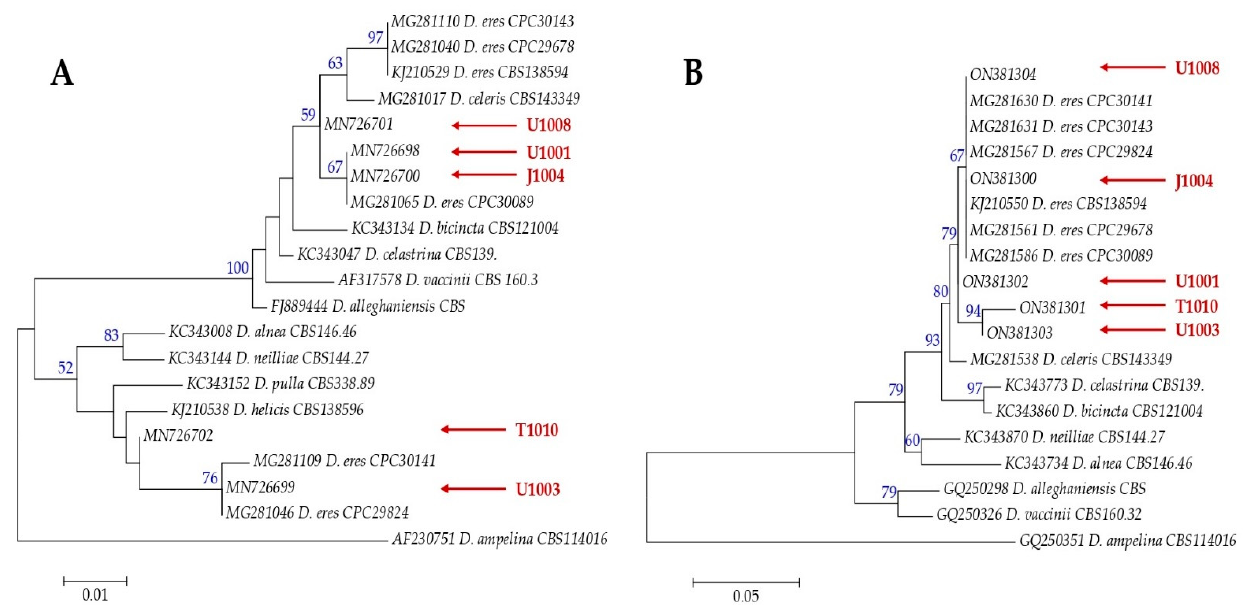
Figure 5. Maximum likelihood phylogenetic trees of the Diaporthe eres species complex. ( A ) ITS and